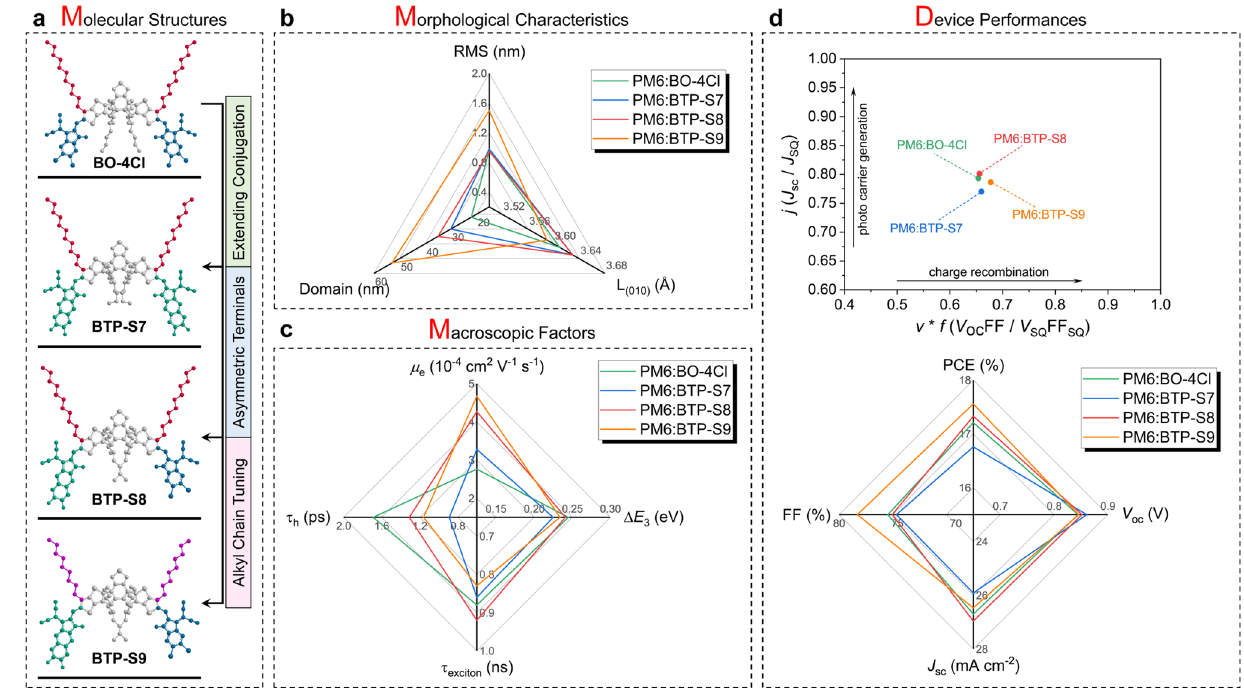
Fig. 6 Correlation analysis. a Molecular structures diagram of BO-4Cl, BTP-S7, BTP-S8, and BTP-S9. b Morphological characteristics matrix of RMS, π – π stacking distance and domain size. c Macroscopic factors matrix of μ e , Δ E 3 , τ exciton (exciton lifetime for pure acceptors) and τ h (total average hole transfer time). d Device performances comparison among four